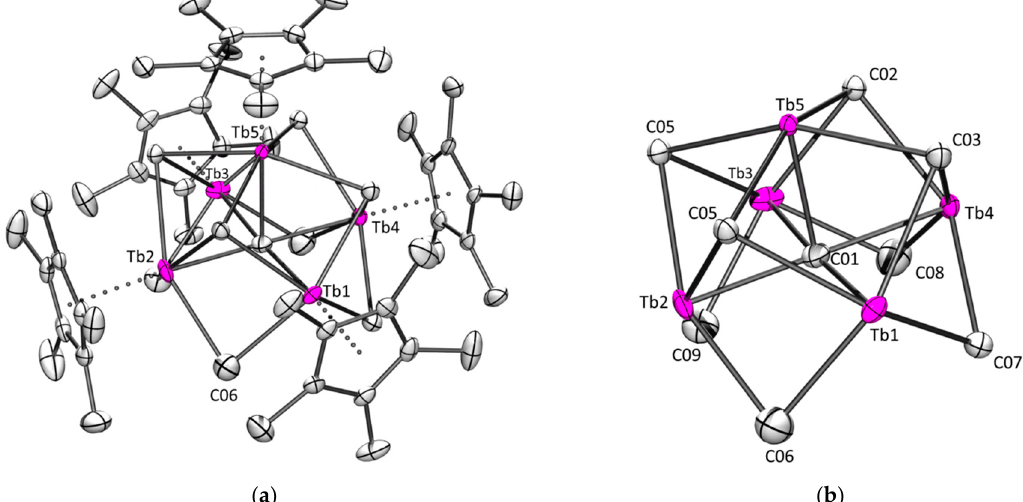
Figure 6. ORTEP view of the crystal structure ( a ) and detailed view on the bonding situation in the core structure ( b ) of [(Cp*Tb) 5 (CH 2 )(Me) 8 ] ( 3 Tb ). Atomic displacement parameters are set at the 50% probability level. Hydrogen atoms and one molecule of n -hexane per asymmetric unit are omitted for clarity. See Table 7 for significant bond lengths and angles.